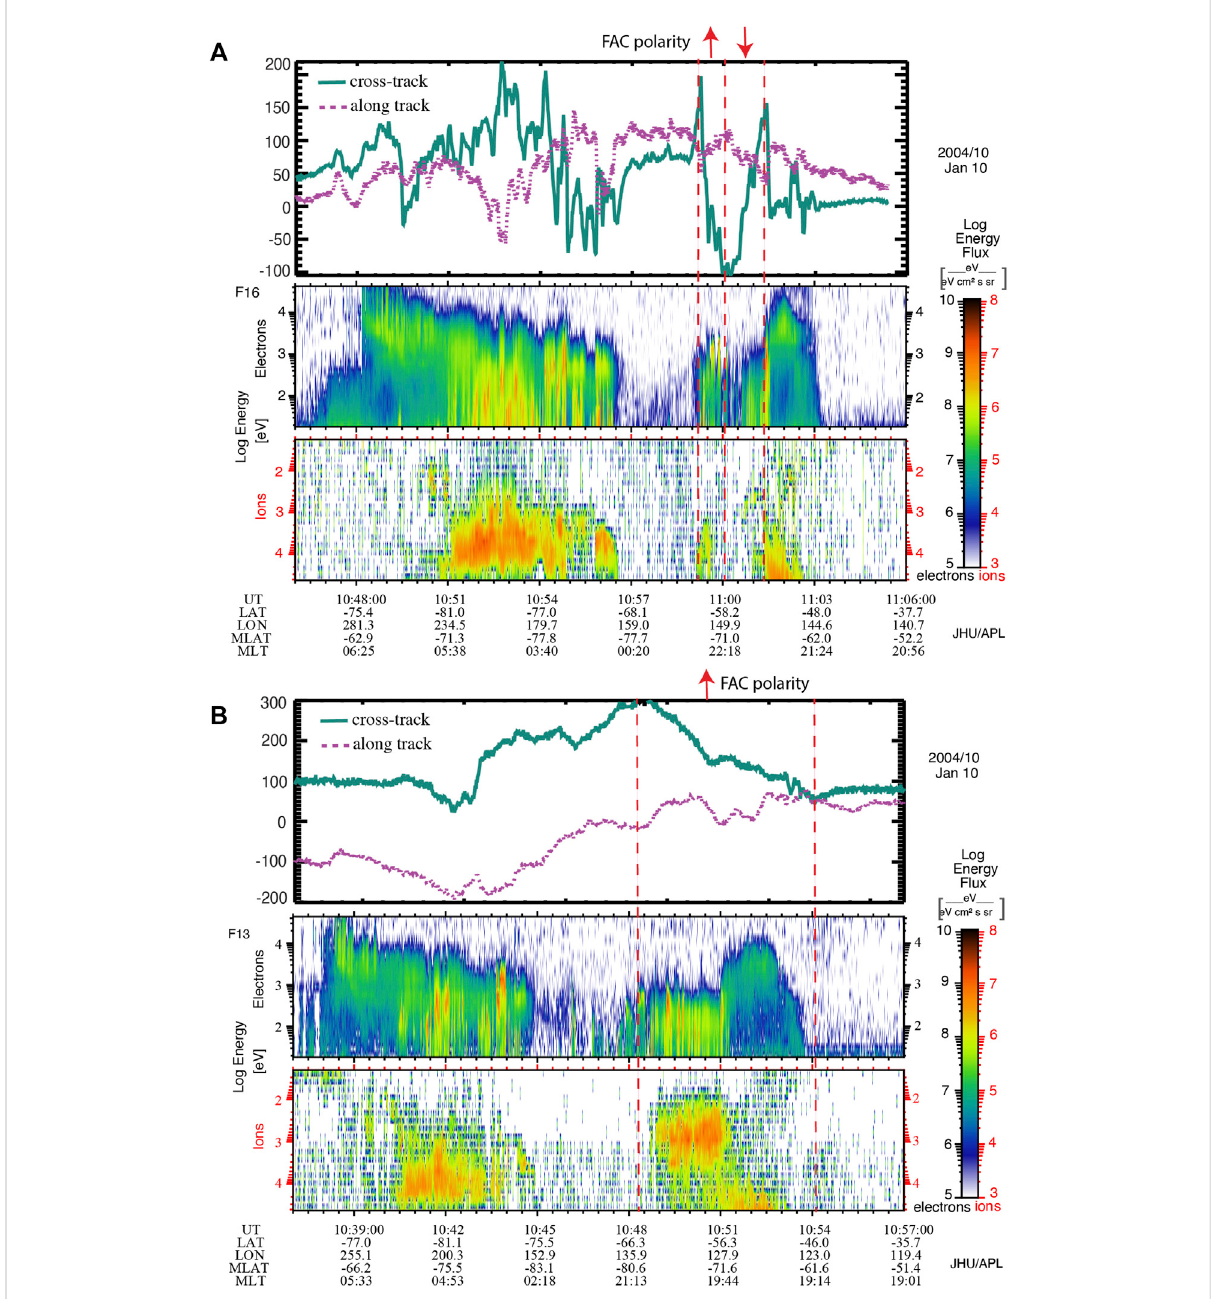
FIGURE 12 (A) (top)A zoom-in of F16 data showing themagnetic fi eld perturbations and associated FAC pair,and the precipitation electrons and ions they occur in. (B) (bottom) Similar observations made by F13 in the southern hemisphere in approximately the same region as F16 but about 1 – 2 h MLT earlier. It is included to put the F16 observations into